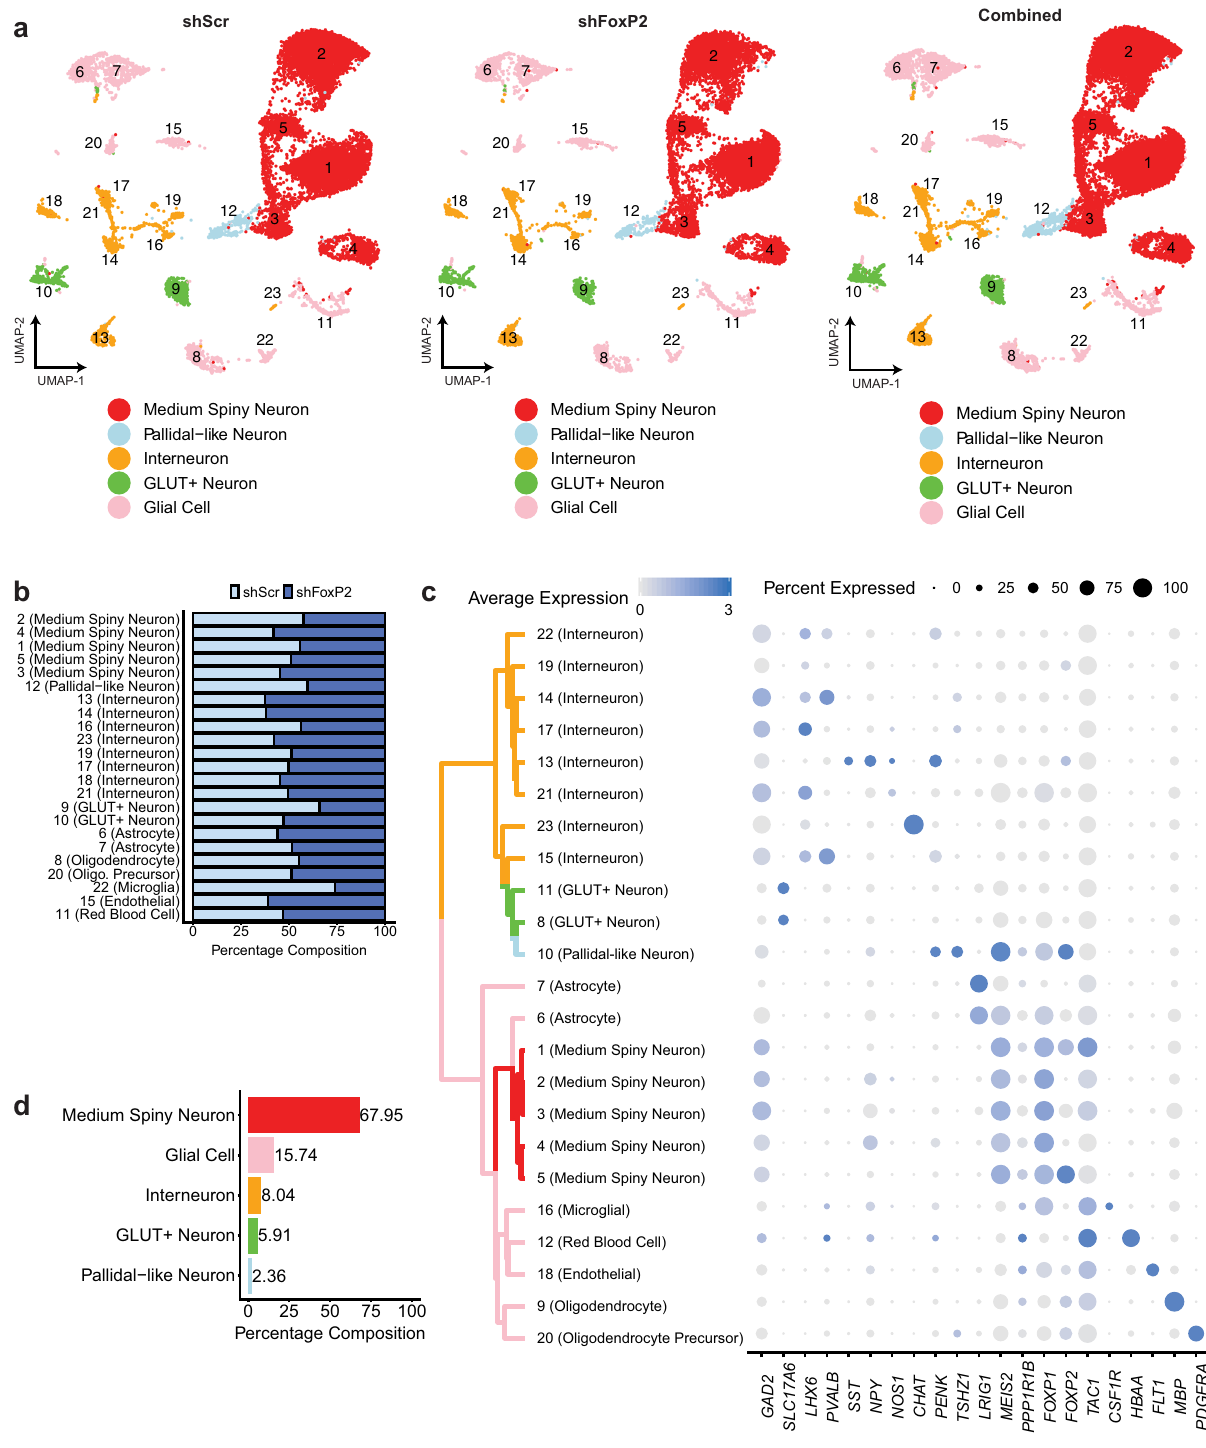
Fig. 4 Overview of cell types in Area X. a UMAP projections of nuclei from Area X (left, shScr subset, n = 14,289; middle, shFoxP2 subset, n = 12,956; right, combined analysis, n = 27,245). Clusters are numbered in ascending order by decreasing size (1-largest; 23-smallest). b Cluster composition by each dataset (shScr or shFoxP2). c Hierarchical clustering and cell type gene marker expression of an independent analysis of the shScr group. For marker gene expression, the size of the dot indicates the percent of nuclei within a cluster expressing a given gene, and the color of the dot indicates the average normalized expression level. d Overall cell type composition in Area X of the shScr